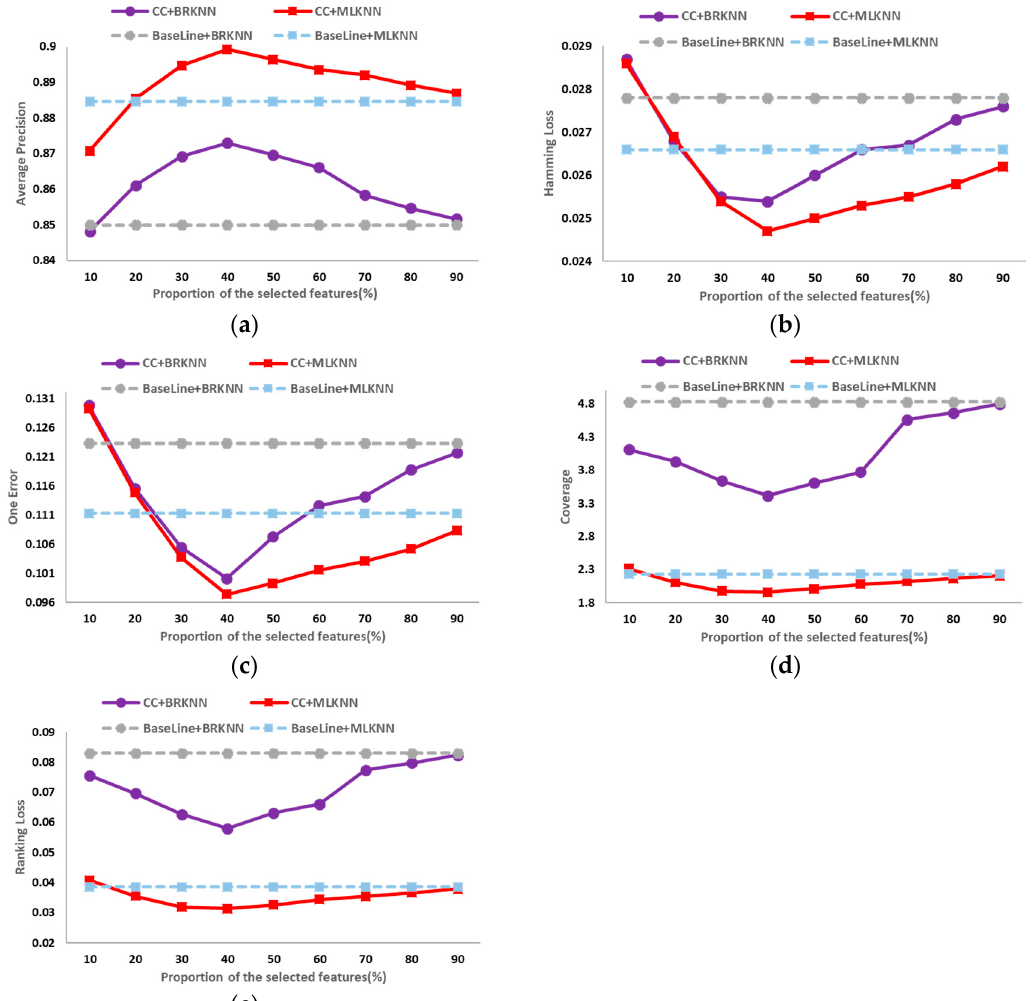
Figure 3. Experimental results on Business data set. ( a ) Average Precision; ( b ) Hamming Loss; ( c ) One Error; ( d ) Coverage; ( e ) Ranking Loss.